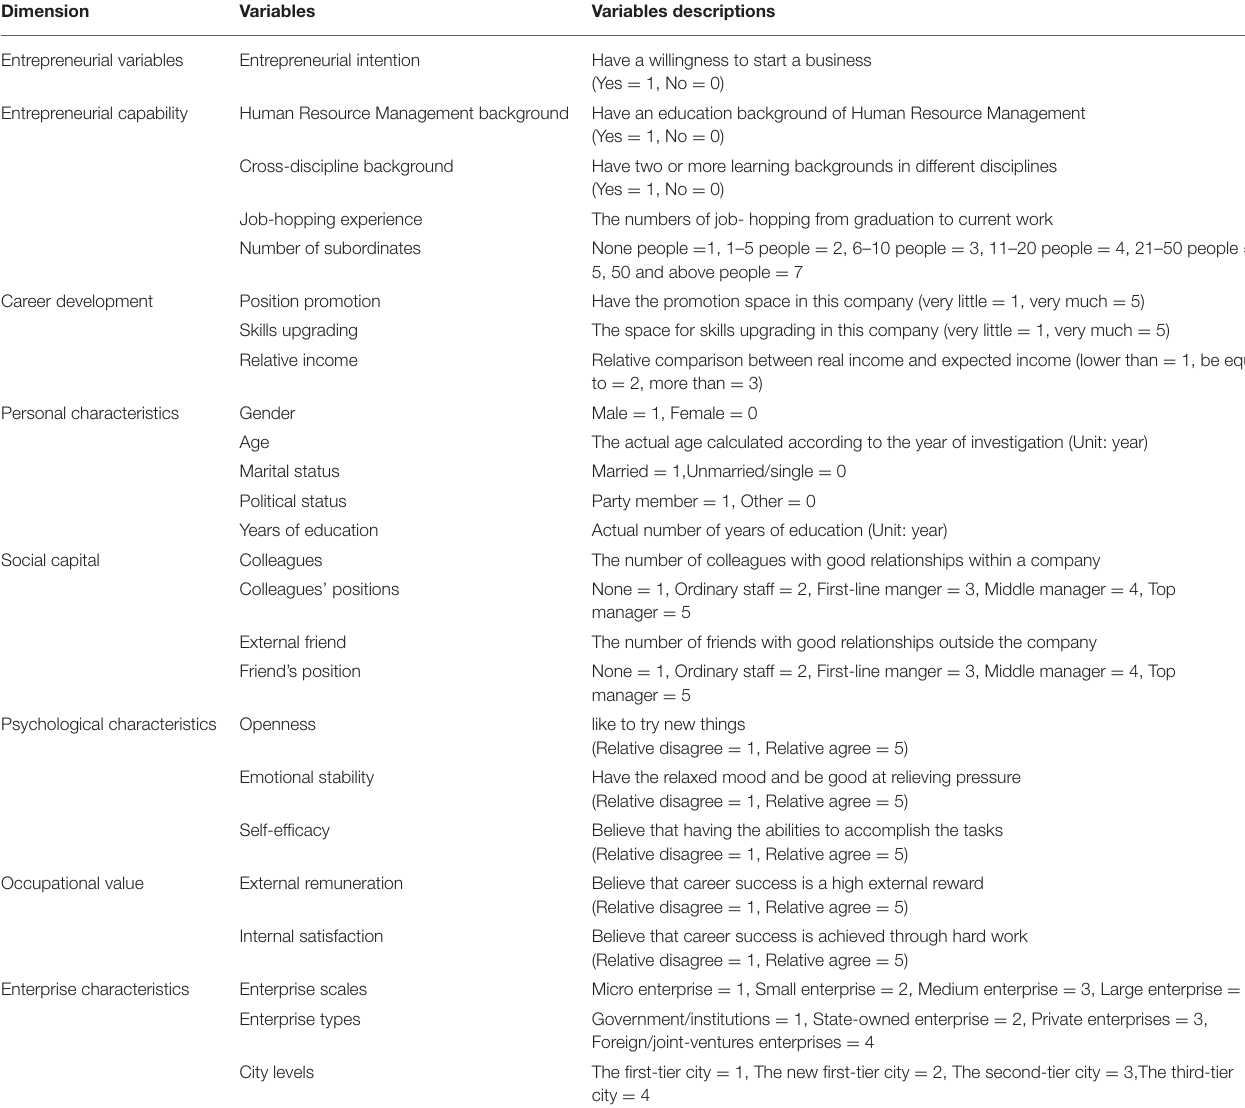
TABLE 1 | Variables and descriptions. Dimension Variables